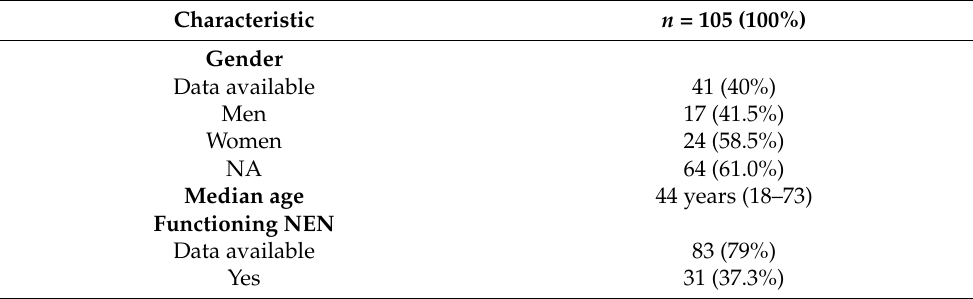
Table 1. Patient